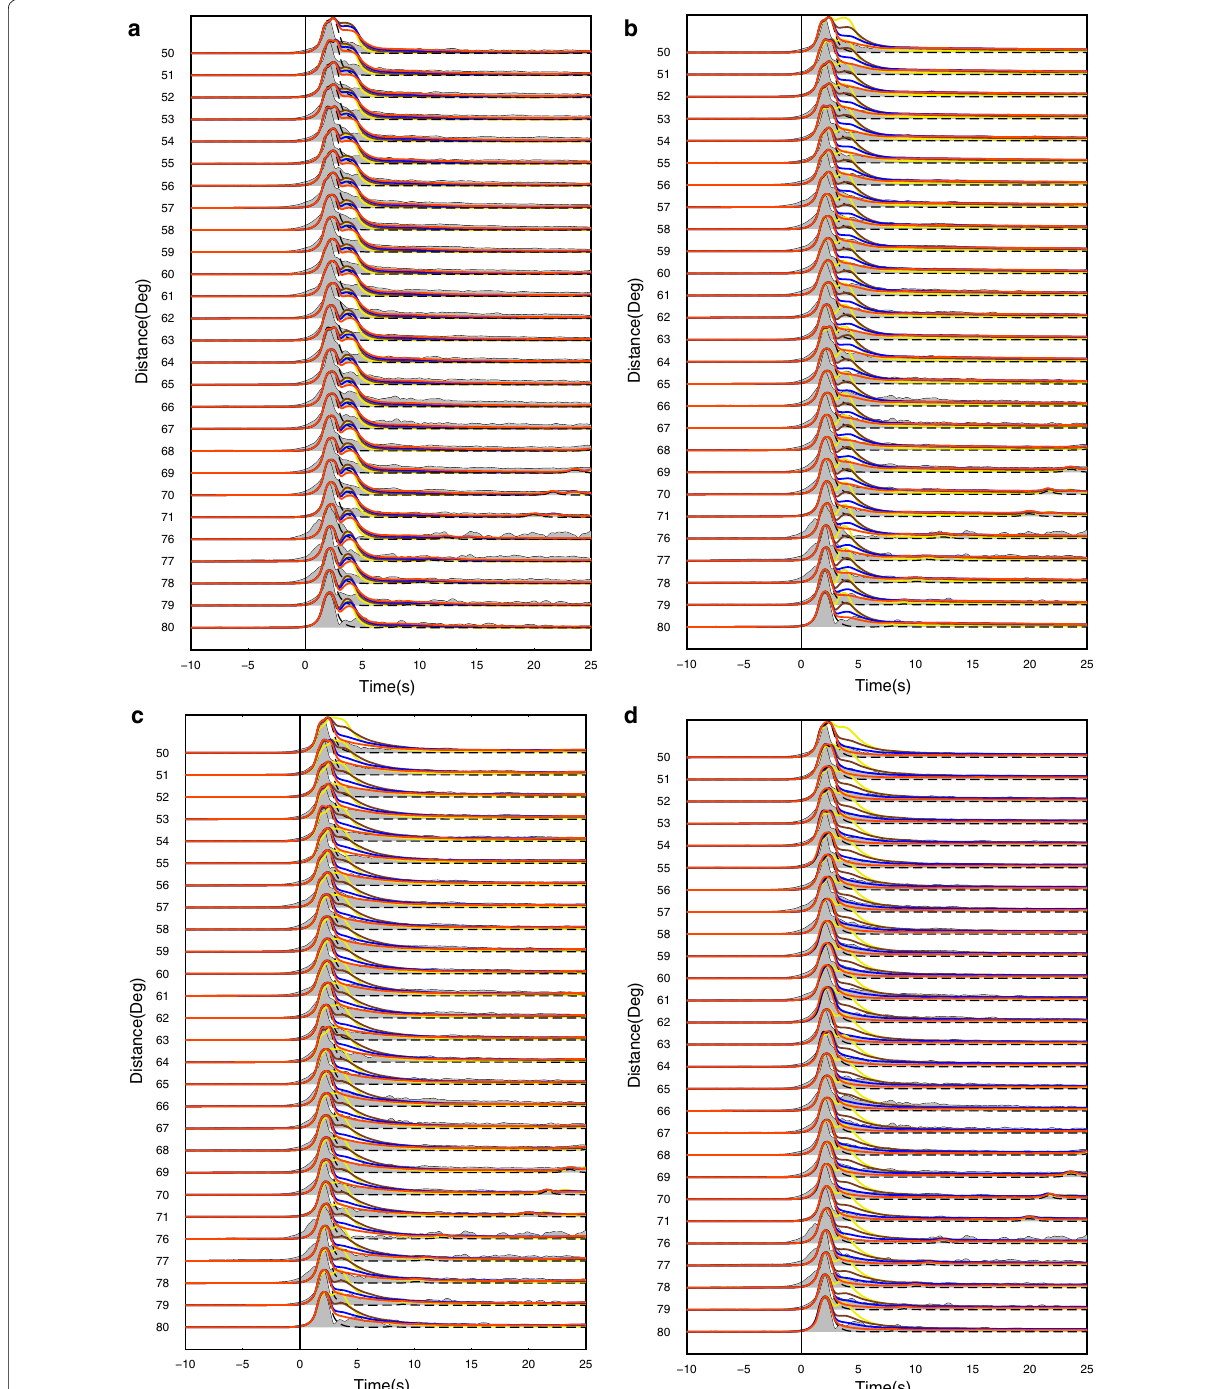
Fig. 9 Synthetics plotted against data stacks. The synthetics are generated by the Monte Carlo simulation for scattering models with different velocity variations and correlation lengths in the upper crust ( a ), whole crust ( b ), lower lithosphere ( c ) and whole lithosphere ( d ), respectively. The grey shading represents stacked data. The dashed lines denote the synthetics computed for the model without any scattering layers. In each column, the yellow, brown, blue and red lines represent the synthetics for models with RMS velocity perturbations ( σ ) of 3%, 5%, 7% and 9% as well as corresponding values of correlation lengths ( a ) in Table 2,